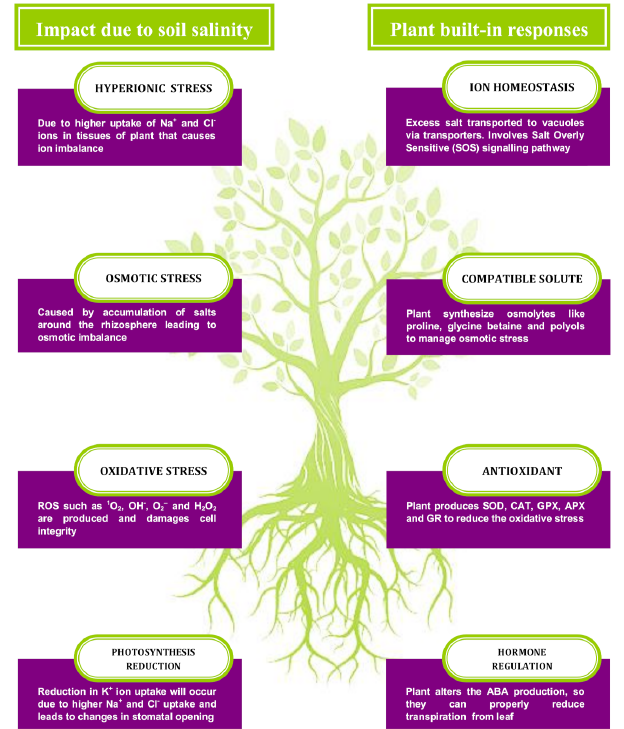
Figure 1. Effects of salt stress on plant characteristics and the plant’s innate stress-response